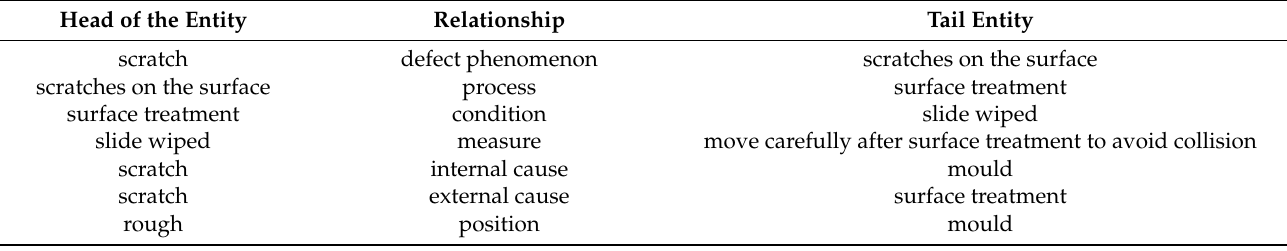
Table 8. Entity relationship extraction.